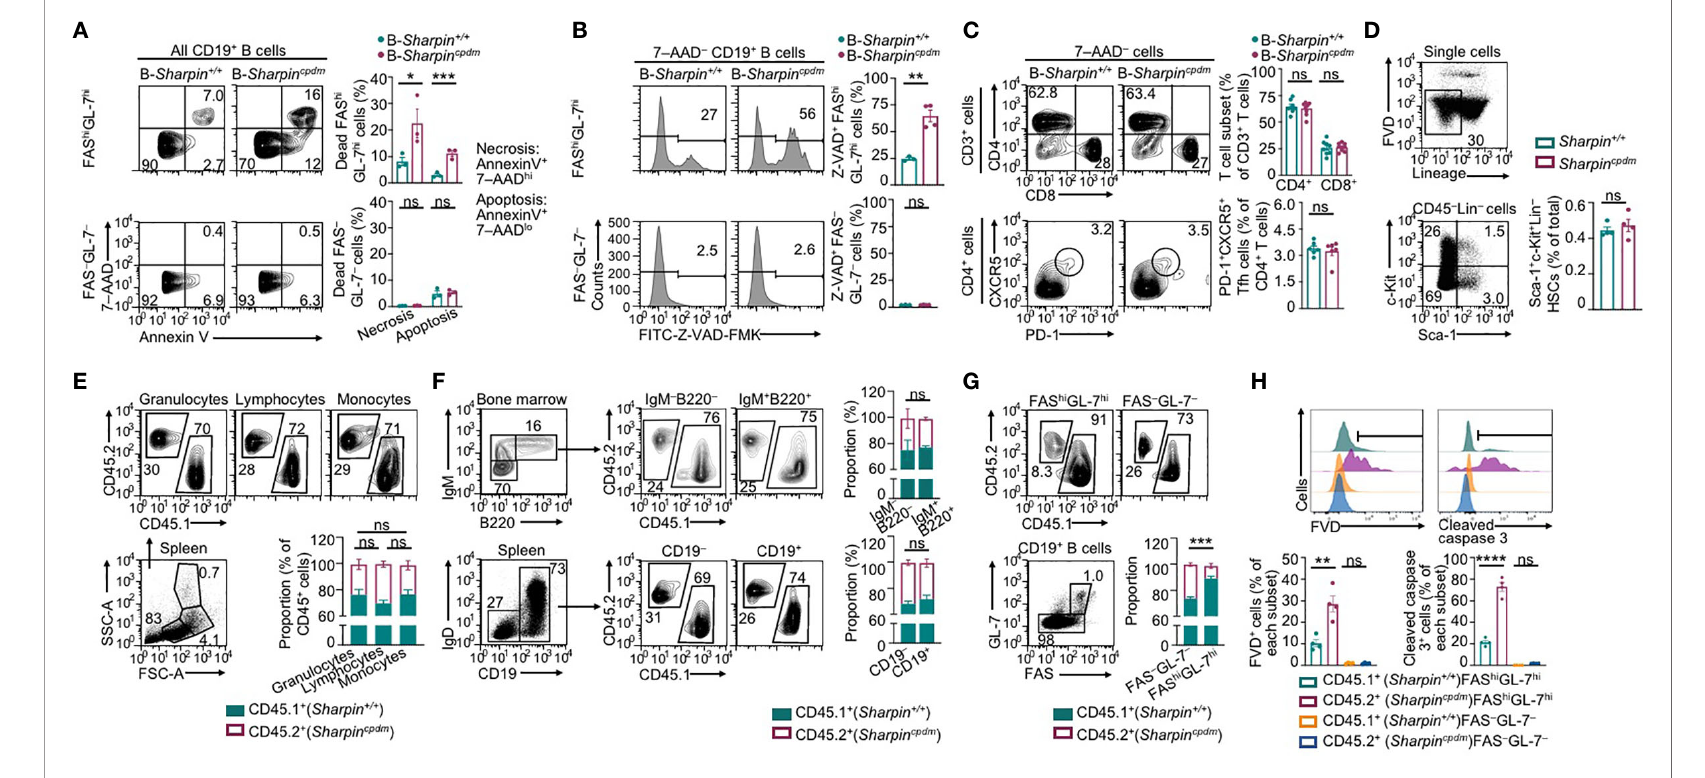
FIGURE 3 | SHARPIN is critical for germinal center B cell survival. (A,B) Flow cytometry analysis of apoptosis and necrosis (A) as well as caspase activation (B) in FAS hi GL-7 hi GC B cells and FAS – GL-7 – non-GC B cells in the spleen of B- Sharpin +/+ or B- Sharpin cpdm mice 14 d after immunization with NP-CGG/alum. (C) Flow cytometry analysis of CD4 + and CD8 + T cells (top panels) as well as CD4 + CXCR5 + PD-1 + Tfh cells (bottom) in mice, as in (A,B) . (D) Gating strategy for fl ow cytometry analysis of Sca-1 + c-Kit + Lin – HSCs and the proportion of such cells in the bone marrow of Sharpin +/+ and Sharpin cpdm mice. (E) Flow cytometry analysis of (SSC hi FSC hi ) granulocytes, (SSC lo FSC lo ) lymphocytes, and (SSC lo FSC hi ) monocytes in the spleen of CD45.1 + Sharpin +/+ / CD45.2 + Sharpin cpdm mixed bone marrow chimera mice (mean and s.d., n=4). (F) Flow cytometry analysis of the proportions of CD45.1 + and CD45.2 + cells in different B cell subsets in the bone marrow and spleen of CD45.1 + Sharpin +/+ / CD45.2 + Sharpin cpdm mice (mean and s.d., n=4). (G, H) Flow cytometry analysis of proportions of CD45.1 + and CD45.2 + cells in FAS hi GL-7 hi GC B cells and FAS – GL-7 – non-GC B cells (G) as well as survival and caspase 3 cleavage (H) in such cells in CD45.1 + Sharpin +/+ / CD45.2 + Sharpin cpdm mice 14 d after NP-CGG/alum immunization (mean and s.d., n=4). * p <0.05; ** p <0.01; *** p <0.001; **** p <0.0001;